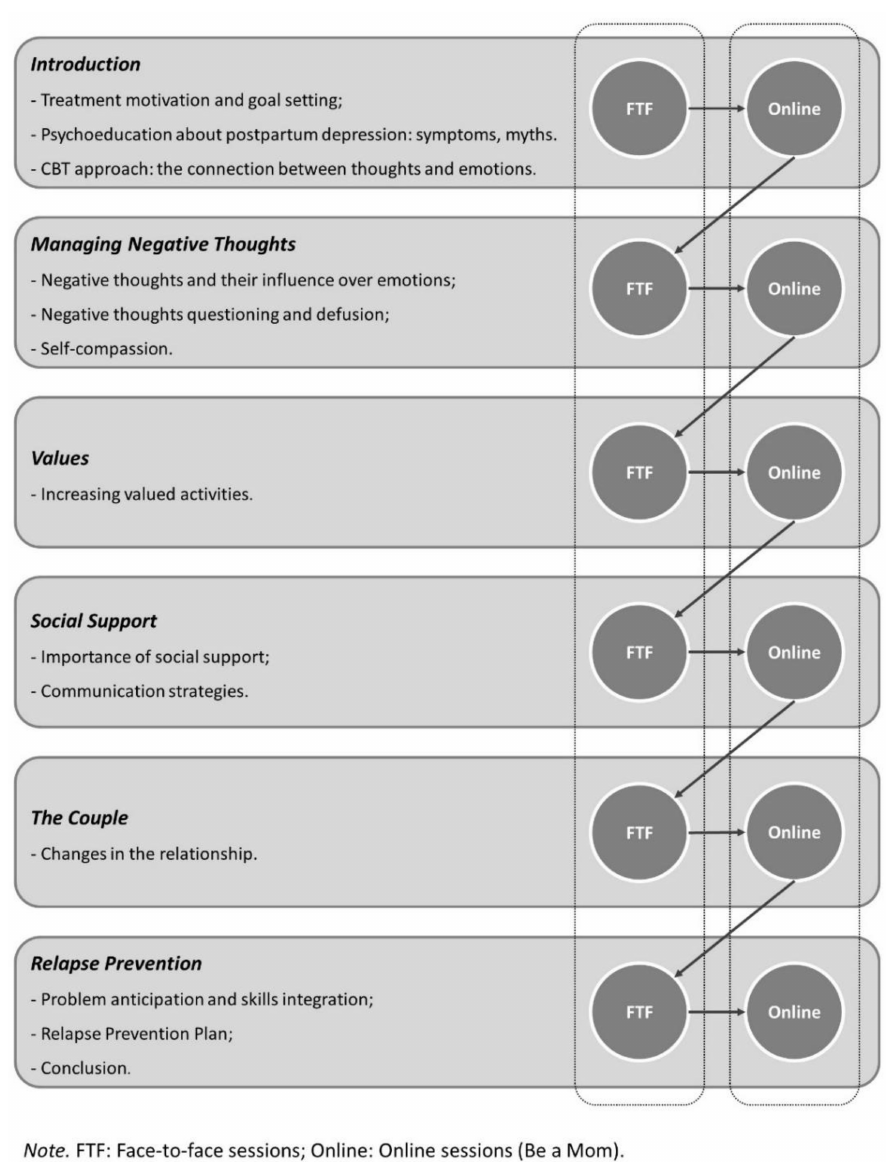
Figure 2. Blended Be a Mom—structure and content of